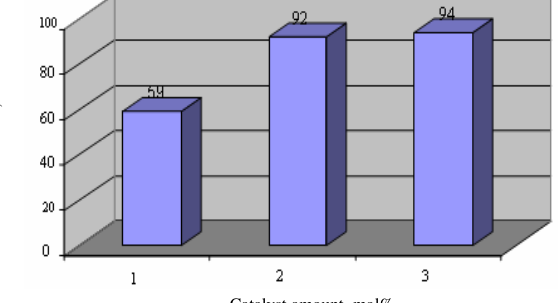
Figure 5. Different amount of PAK heteropolyacid for synthesis of β -acetamido- β - (4chlorophenyl)